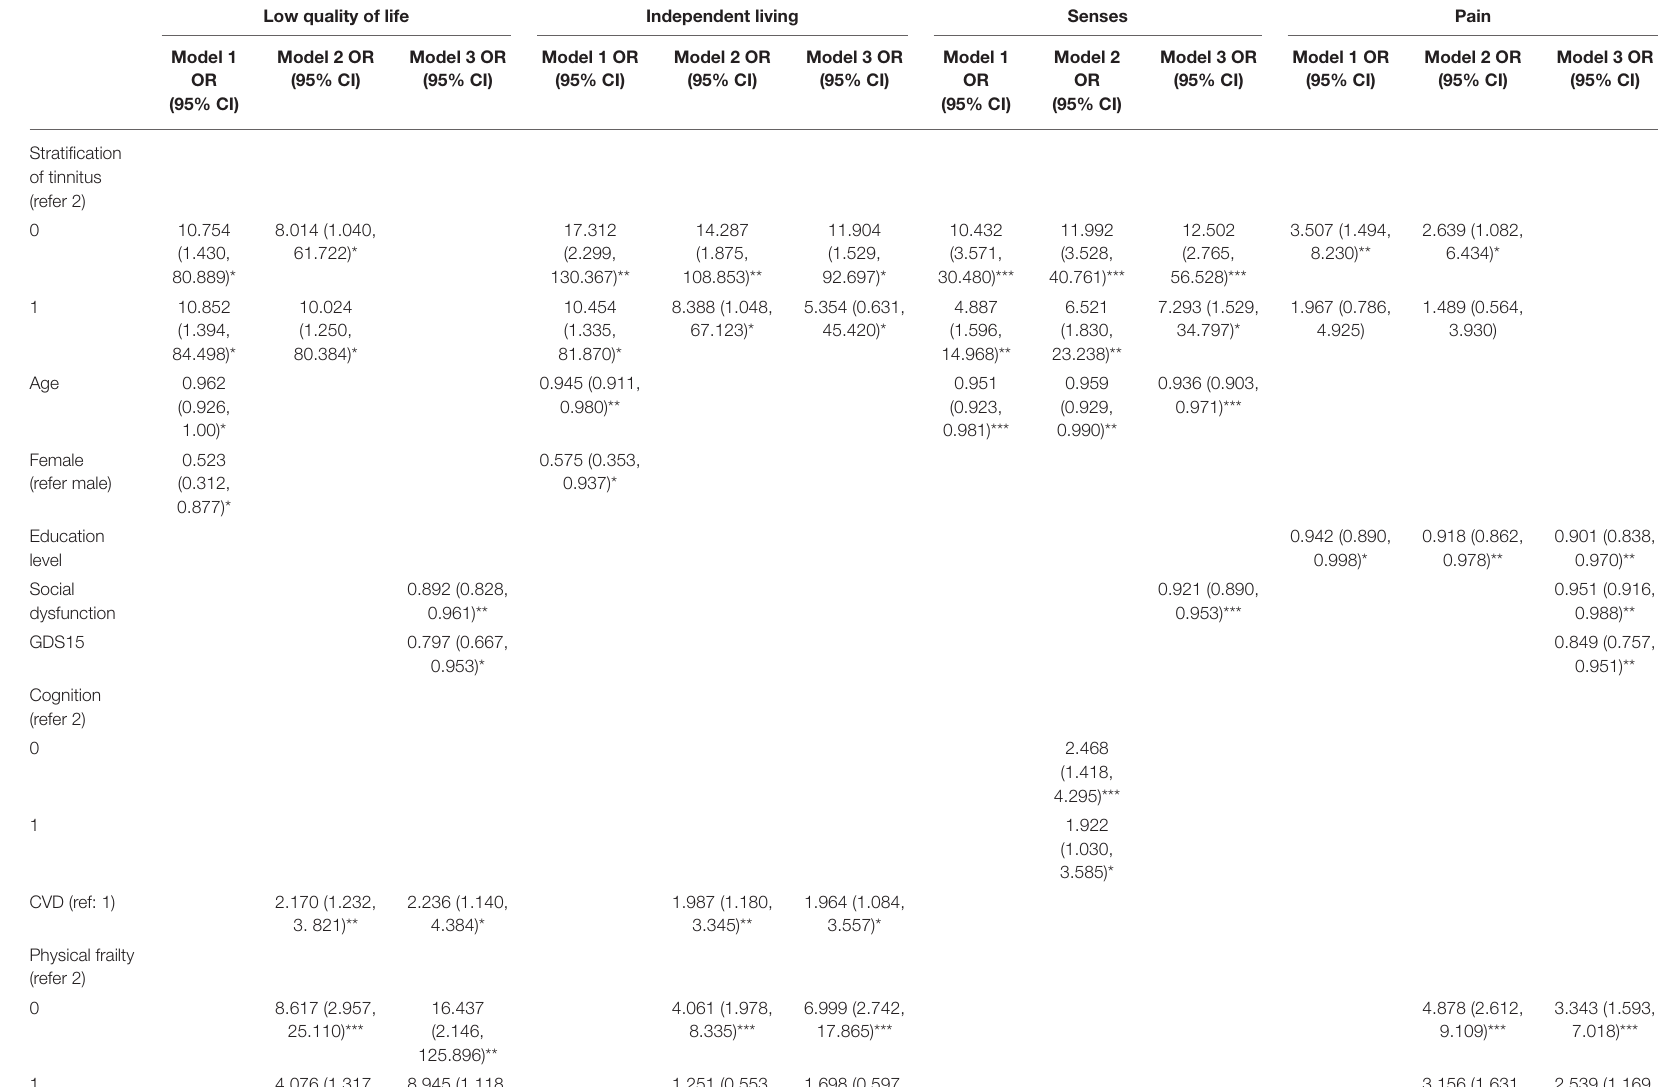
TABLE 4 | Multiple logistic regression analysis of the association of tinnitus severity with high quality of life (low scores) and low subscores of domain-specific quality of